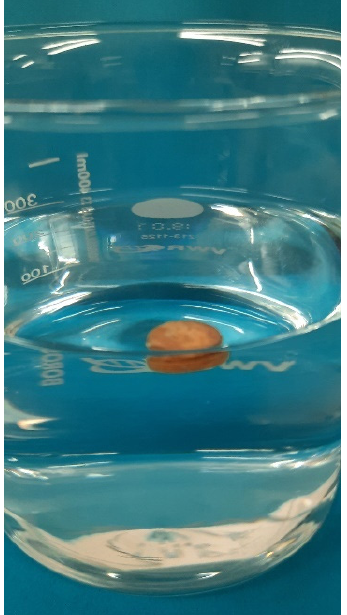
Figure 7. Floating properties of PP1 in 300 mL 0.1 N HCl, 37 ± 0.5 °C.